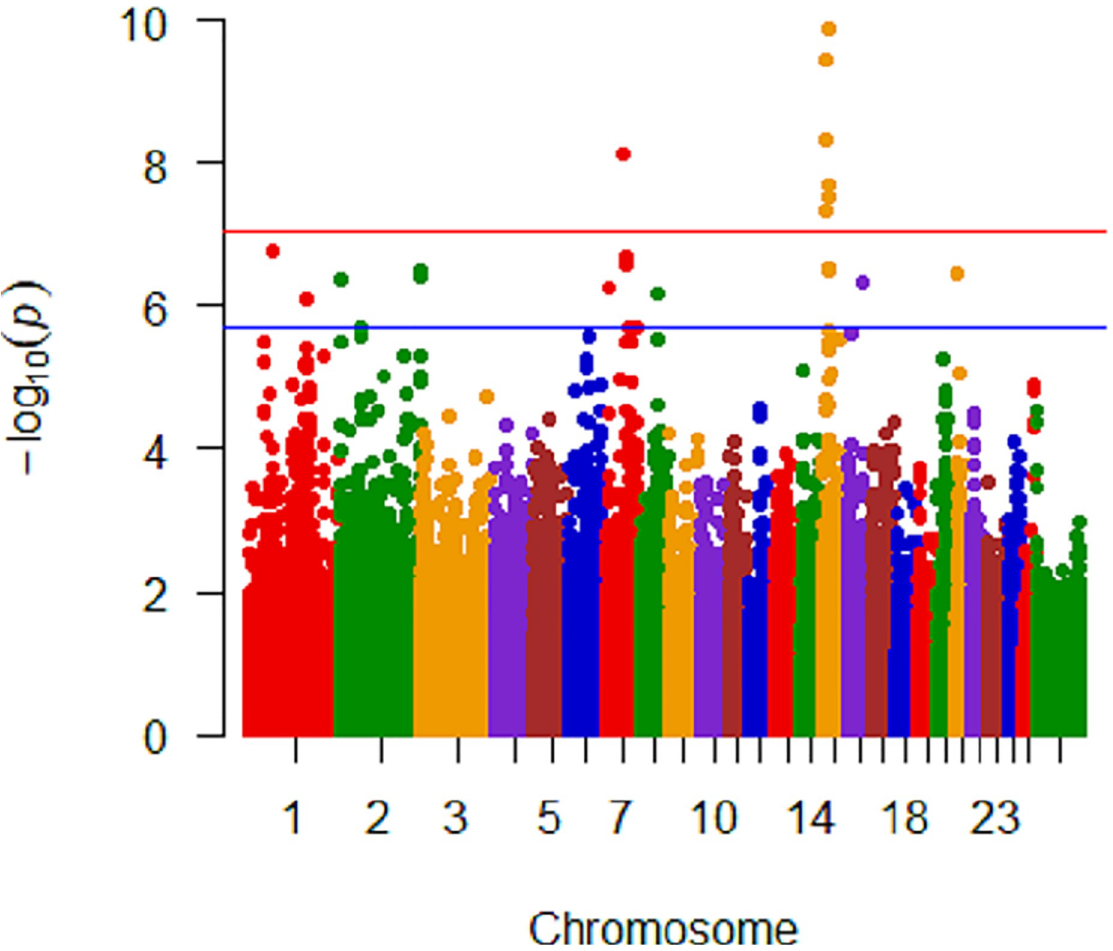
Fig 6. Manhattan plot of Suffolk analysis with untransformed M . ovipneumoniae mean DNA copy number. Significant SNPs are on chromosomes 7 and 15 Genome significant line is red and genome suggestive line is blue. https://doi.org/10.1371/journal.pone.0247209.g006 in T cell activation [55], it is specifically expressed in Th17 T cells [56] and has variable expres- sion in T cells of people with Rett Syndrome [57]. In addition, PTPN13 is a conserved tran- script in innate lymphoid cell type 2 (ILC2), which are considered helper-like and found in upper and lower airway and blood of humans [58] and mice [59]. In mouse lung, ILC2s were found to proliferate upon intranasal application of allergens, and memory-like lung ILC2s dis- played upregulated expression of cytokines and their respective receptors, but also receptors for alarmins ( IL25R , ST2 ), and genes associated with cell activation and proliferation ( BCL2A1B , IER3 ) [60]. Also, PTPN13 (PTP-BL) interacts with the Rho effector kinase protein kinase C-related kinase 2 ( PRK2 ) [61] and PRK2 has been demonstrated to have a role in cilia signaling [62] as well as regulation of the formation of apical junctions in bronchial epithelial cells [63]. Infection of a murine macrophage cell line with M . ovipneumoniae increases levels of nucleotide-binding oligomerization domain-containing 2 ( NOD2 ) and NOD2 along with acti- vation of c -Jun NH2-terminal protein kinase ( JNK ) induces autophagy [64]. NOD2 interacts with RAC family small GPTase 1 ( Rac1 ) in membrane ruffles [65] and it has been suggested that Rho GTPases such as Rac1 regulate PRK2 activity during control of the cell cycle [66].